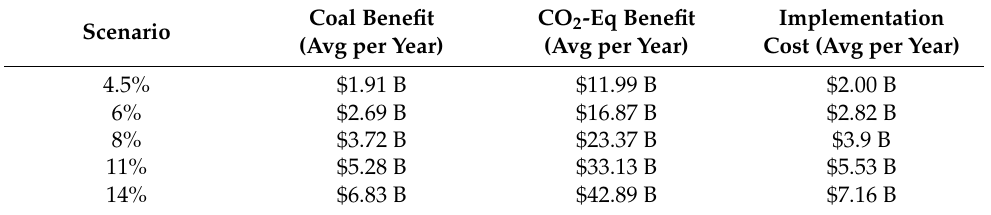
Table 7. Implementation cost of PHS plants compared with coal avoided and EU ETS